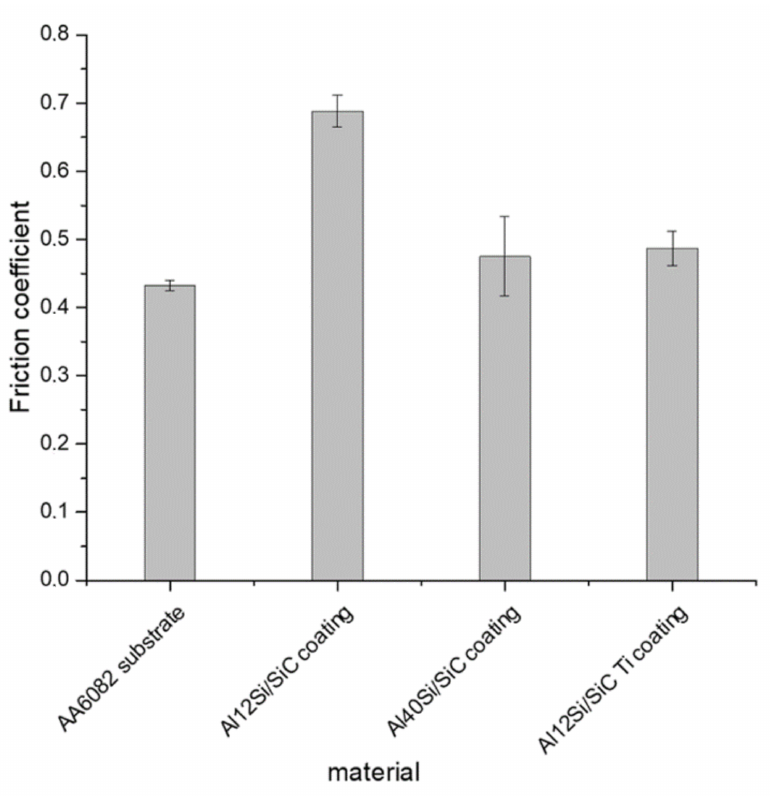
Figure 4. Average friction coefficient for the substrate and coatings on the AA6082 aluminum